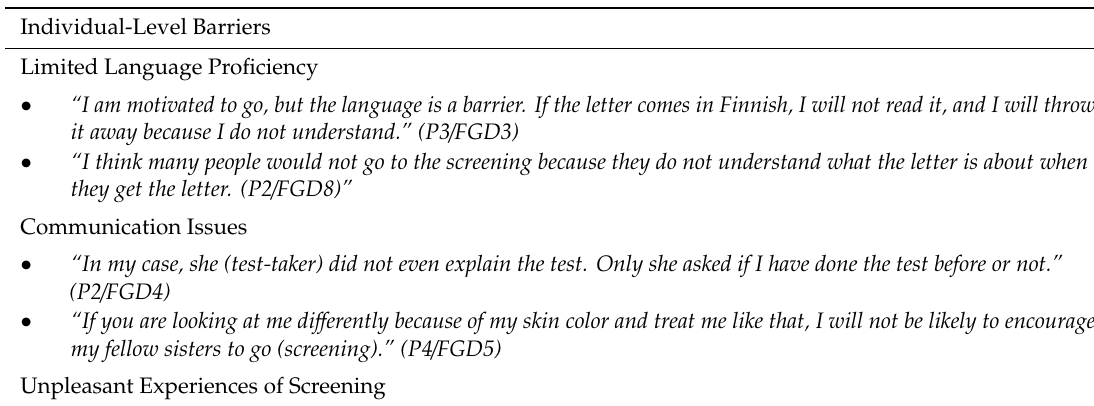
Table 3. Examples of quotations of barriers to cervical cancer screening (CCS)